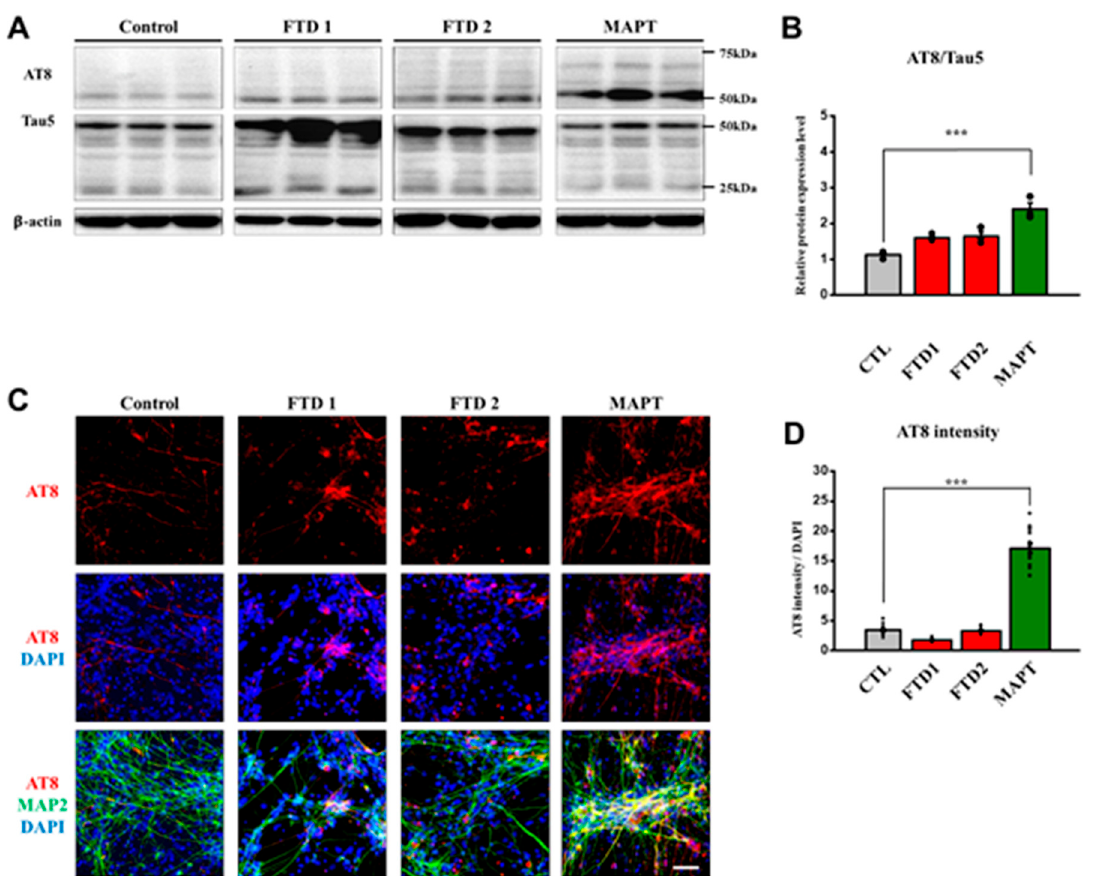
Figure 4. Characterization of phosphorylated tau expression pattern in the bvFTD iPSC-derived neurons. ( A ) Immunoblot assay showing a significant increase of phosphorylated tau (AT8), and total tau (Tau5) proteins in the FTD iPSC-derived neurons. Note that blot images indicated by dividing lines were chosen from di ff erent immunoblots due to the large size of samples. Protein quantifications were conducted under the same exposure time. Whole blot images are provided in Supplementary Figure S3E. ( B ) Quantification of AT8 expression against its own total tau (tau 5) expression in the iPSC-derived neurons ( n = 3) (*: vs. normal control) * p < 0.05, ** p < 0.01, and *** p < 0.001, one-way ANOVA ( C ) Immunocytochemical assay showing the expression of AT8 (red) and MAP2 (green), which were counter-stained with DAPI (blue), in the iPSC-derived neurons at three weeks of neuronal di ff erentiation. Scale bar: 100 µ m. ( D ) Quantification of the intensity of AT8 protein expression with respect to MAP2-positive neurons, which were normalized against DAPI ( n = 16) (*: vs. control) * p < 0.05, ** p < 0.01, and *** p < 0.001, one-way ANOVA.